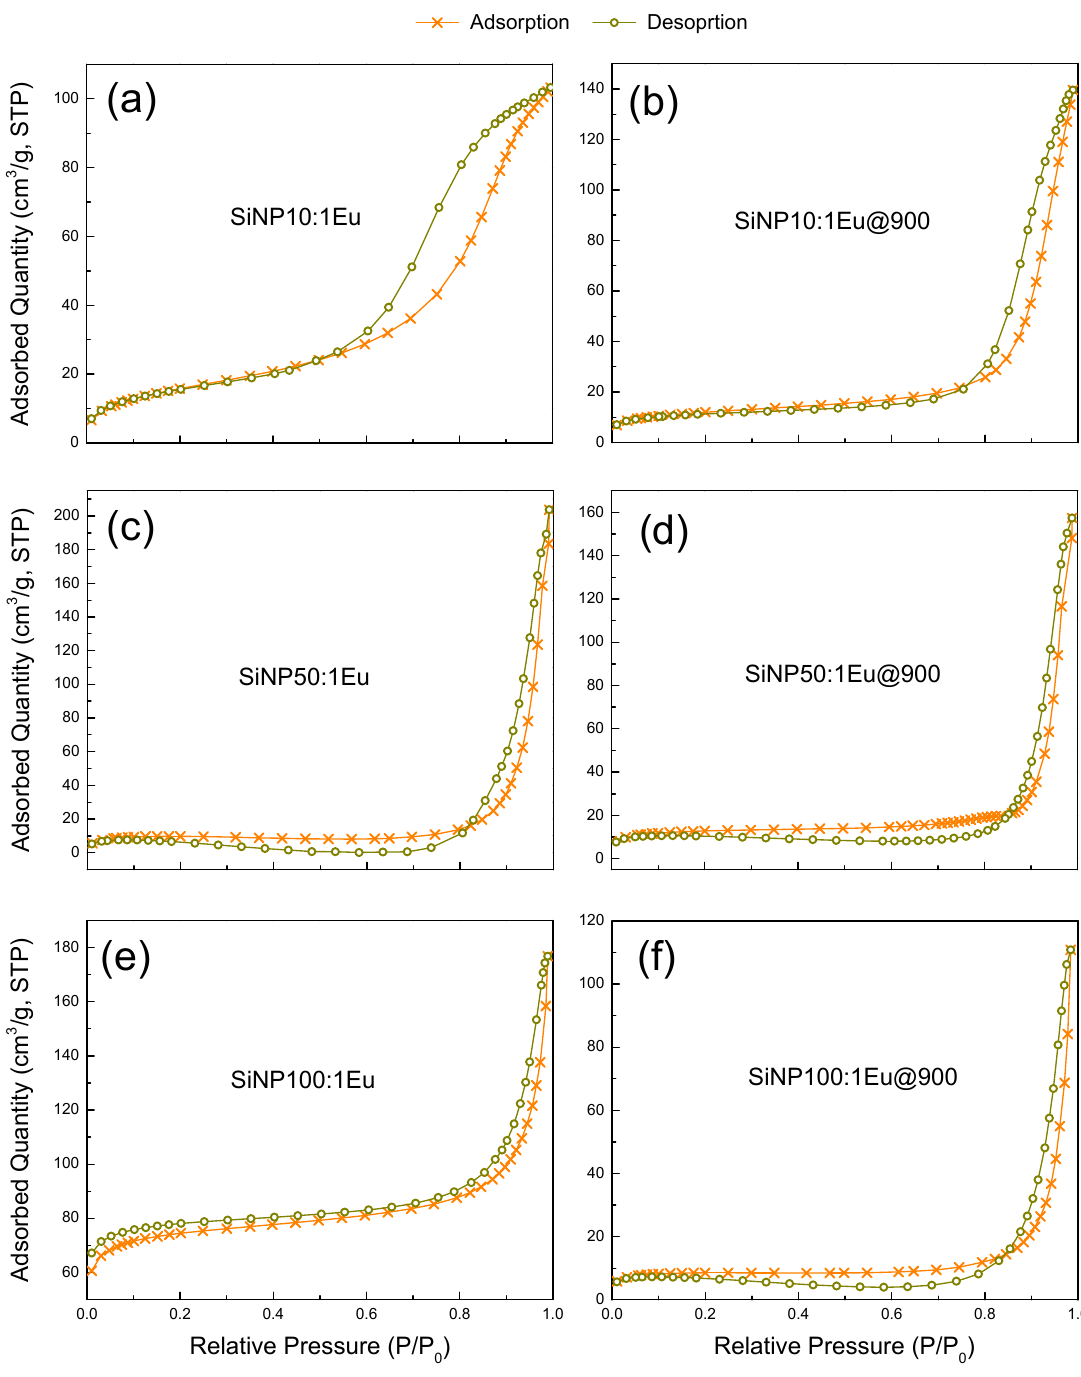
Figure 2. Adsorption-desorption isotherms of all SiNPX:1Eu and all SiNPX:1Eu@900 . In comparison with the Eu-doped silica bulk, the thermal treatment induces the same effect on the surface areas of the nanoparticles. For all silica nanoparticles, the thermal treatment results in a reduction of the surface area of 30, 25 and 89% for SiNP10:1Eu , SiNP50:1Eu and SiNP100:1Eu , respectively, which follows a similar line to the densification observed by TEM for SiNP10:1Eu and SiNP50:1Eu. The large reduction of the surface area of SiNP100:1Eu particles is attributed to their preparation with the Stöber method which leads to softer particles. On the other hand, the pore volume decreases after thermal treatment for all samples except for SiNP10:1Eu , where it increases, which